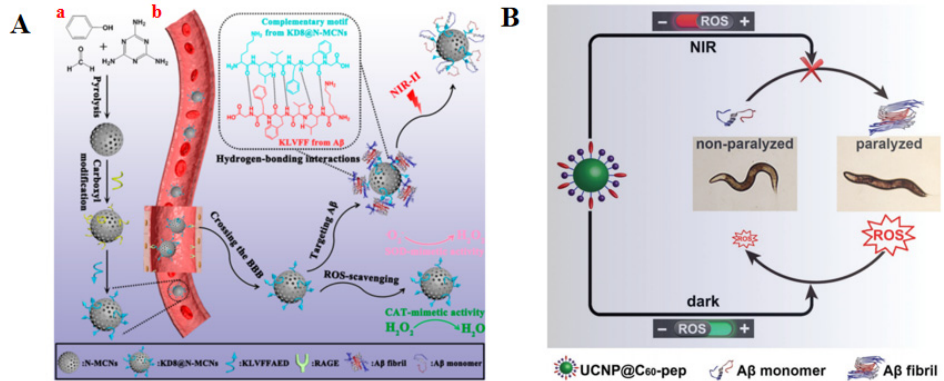
Figure 5. ( A ) (a) Schematic chart of KD8@N-MCNs synthesis and (b) schematic diagram of the KD8@N-MCNs mechanism of action. Reprinted with permission from reference [82]. Copyright 2020 American Chemical Society. ( B ) Schematic of UCNP@C 60 -PEP inhibiting A β aggregation in vivo and attenuating the oxidative stress to prolong the lifespan of the CL2006 strain. Reprinted with permission from reference [95]. Copyright 2018 Wiley-VCH.